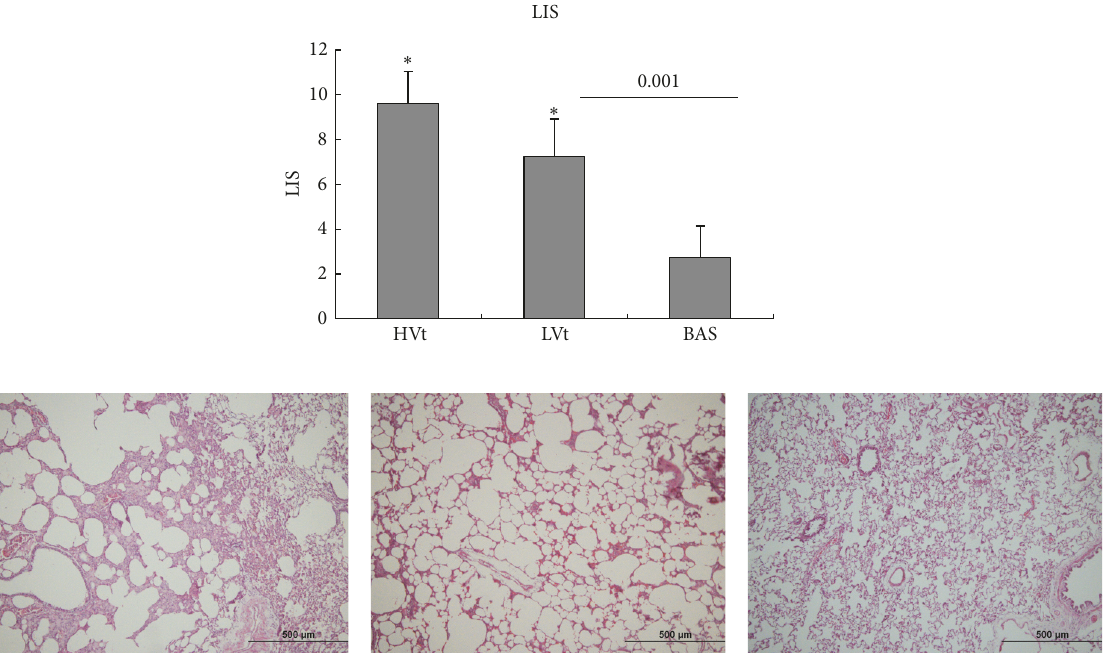
Figure 2: Representative images of lungs in each group after haematoxylin and eosin staining and associated LISs . Lung tissue of the MV group showed obvious damage, including significant alveolar oedema, haemorrhage, inflammatory cell infiltration, alveolar septal thickening, and alveolar overexpansion or atelectasis. LIS increased with MV and was significantly higher in the HVt group compared with that in the LVt group. Results are represented as the mean ± SD. ∗ 𝑃 < 0.013 versus the basal group. 𝑁 = 8 animals per group. MV, mechanical ventilation; BAS, basal; LVt, low tidal volume; HVt, high tidal volume; LIS, lung injury